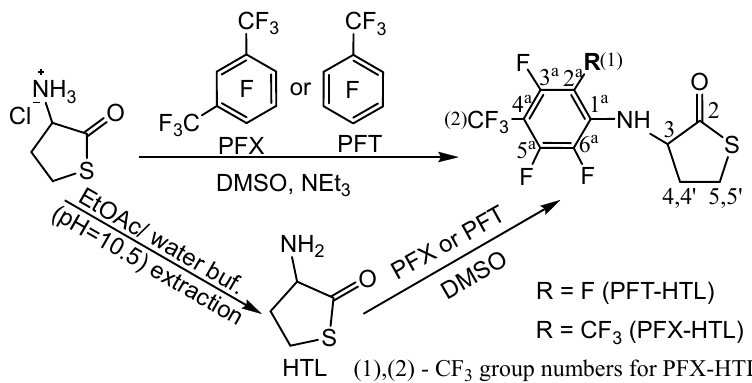
Figure 1. Synthesis of the fluorinated N -substituted HTL derivatives.